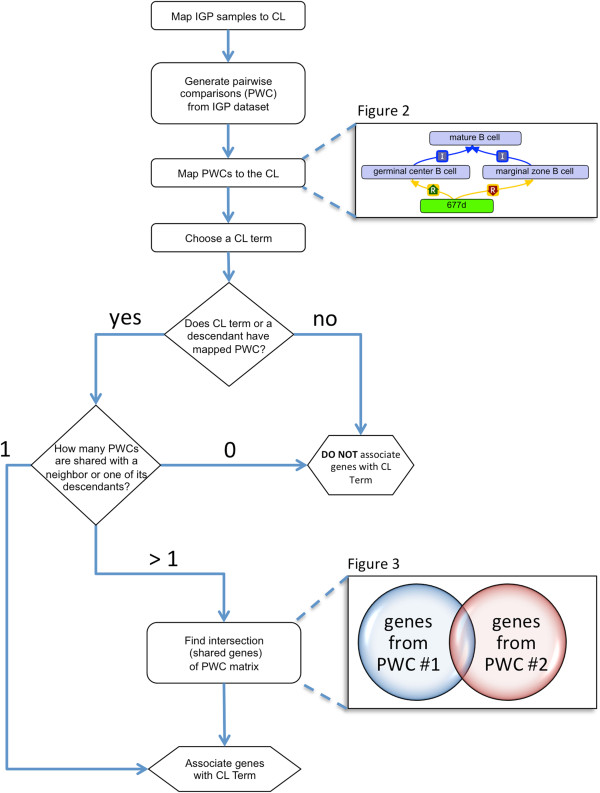
Workflow of OBAMS project. The project starts with a set of pairwise comparisons that are mapped to the Cell Ontology (CL) (Figure 2A). A user will check to see if a CL term of interest has a pairwise comparison mapped directly to it, or to one of its is_a descendants in the ontology (Figure 2B, Figure 2C). If yes, then a user determines if any pairwise comparisons are shared with their nearest neighbors (i.e. siblings) or any of their descendants. If more than one pairwise comparison exists, then shared genes are found among all the relevant gene sets (Figure 3).